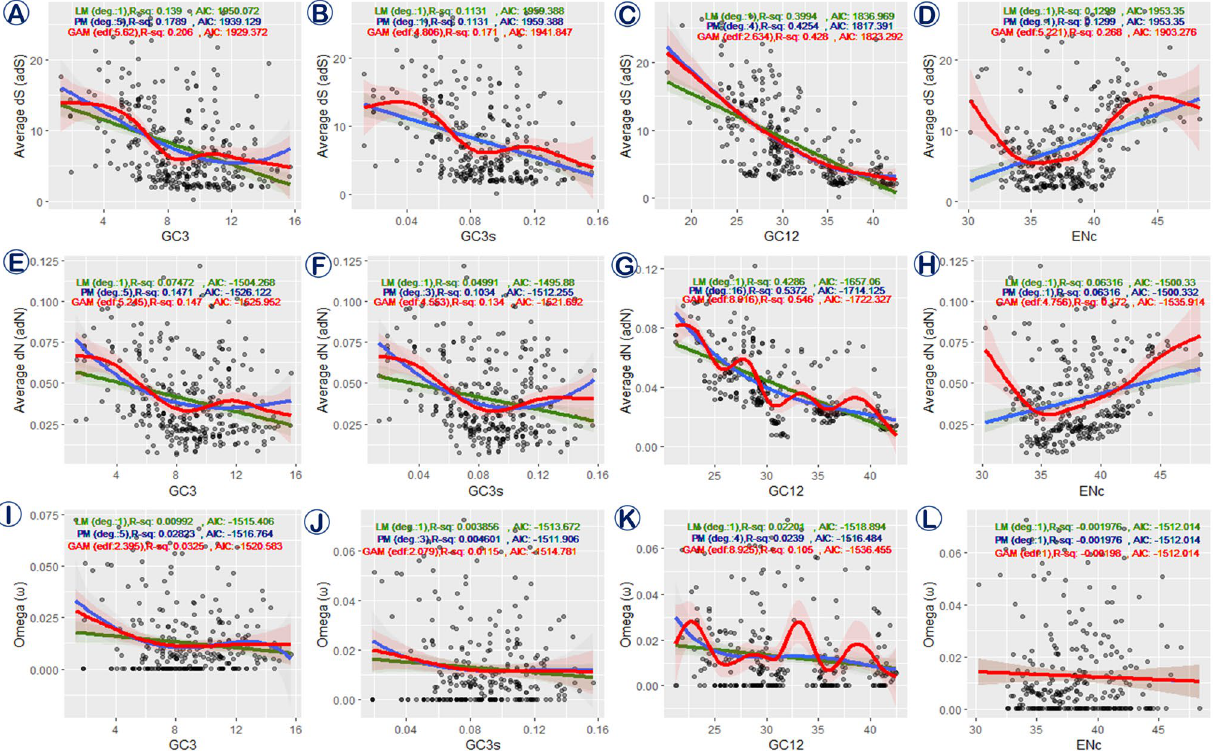
Figure 9. Univariate regression model fitting between response variables, divergence rate (dS, dN and ω) and predictor variables, codon usage indices (GC3, GC3s, GC12, ENc) of training datasets; ( A – D ): average synonymous divergence (adS) rate vs codon usage indices; ( E – H ): average nonsynonymous divergence rate (adN) vs codon usage indices; ( I – L ): omega ratio (ω) vs codon usage indices; Green: Linear Model (LM), Blue: Polynomial Model (PM), Red: Generalized Additive Model (GAM), light colour represent the 95% confidence interval; R-sq (R 2 ): Coefficient of determination; AIC: Akaike information criterion; deg: degree, edf: effective degrees of